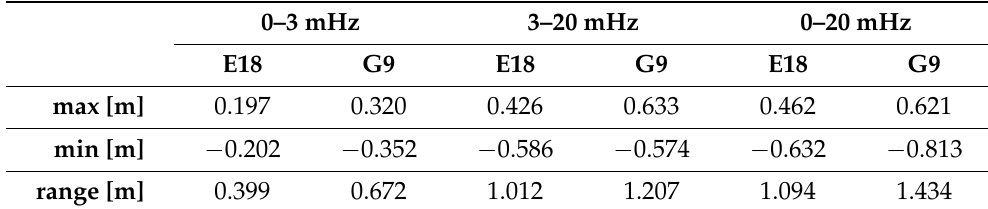
Table 4. Maximum code multipath errors determined from decomposition of signal for specified satellites.